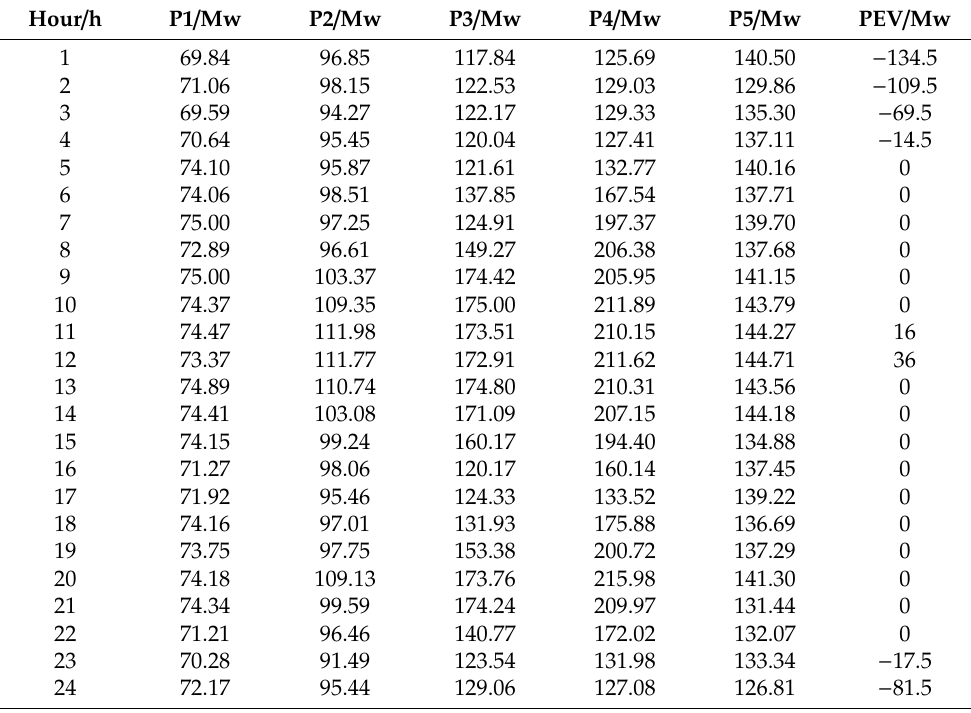
Figure 10. New 24-h load curve after valley filling and peak shaving. Table 6. 24-h output of per unit under optimal scheduling in Case 3.